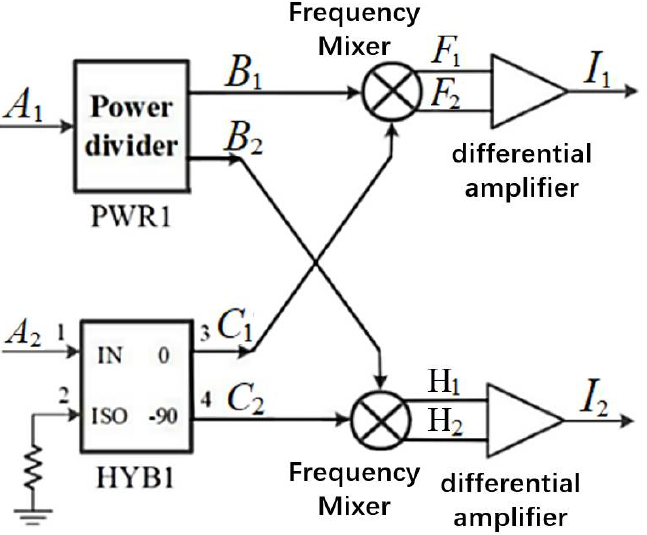
Figure 13. Block diagram of a multiplicative analog complex correlator. When the input of the multiplicative analog complex correlator is as shown in Equation (14), signals F 1 , F 2 , H 1 , and H 2 are passed through a di f f erential ampli f ier (the gains of the differential amplifier are G 1 and G 2 , respectively) and an ideal low-pass filter, whereby output signals I 1 and I 2 are obtained, which are expressed as